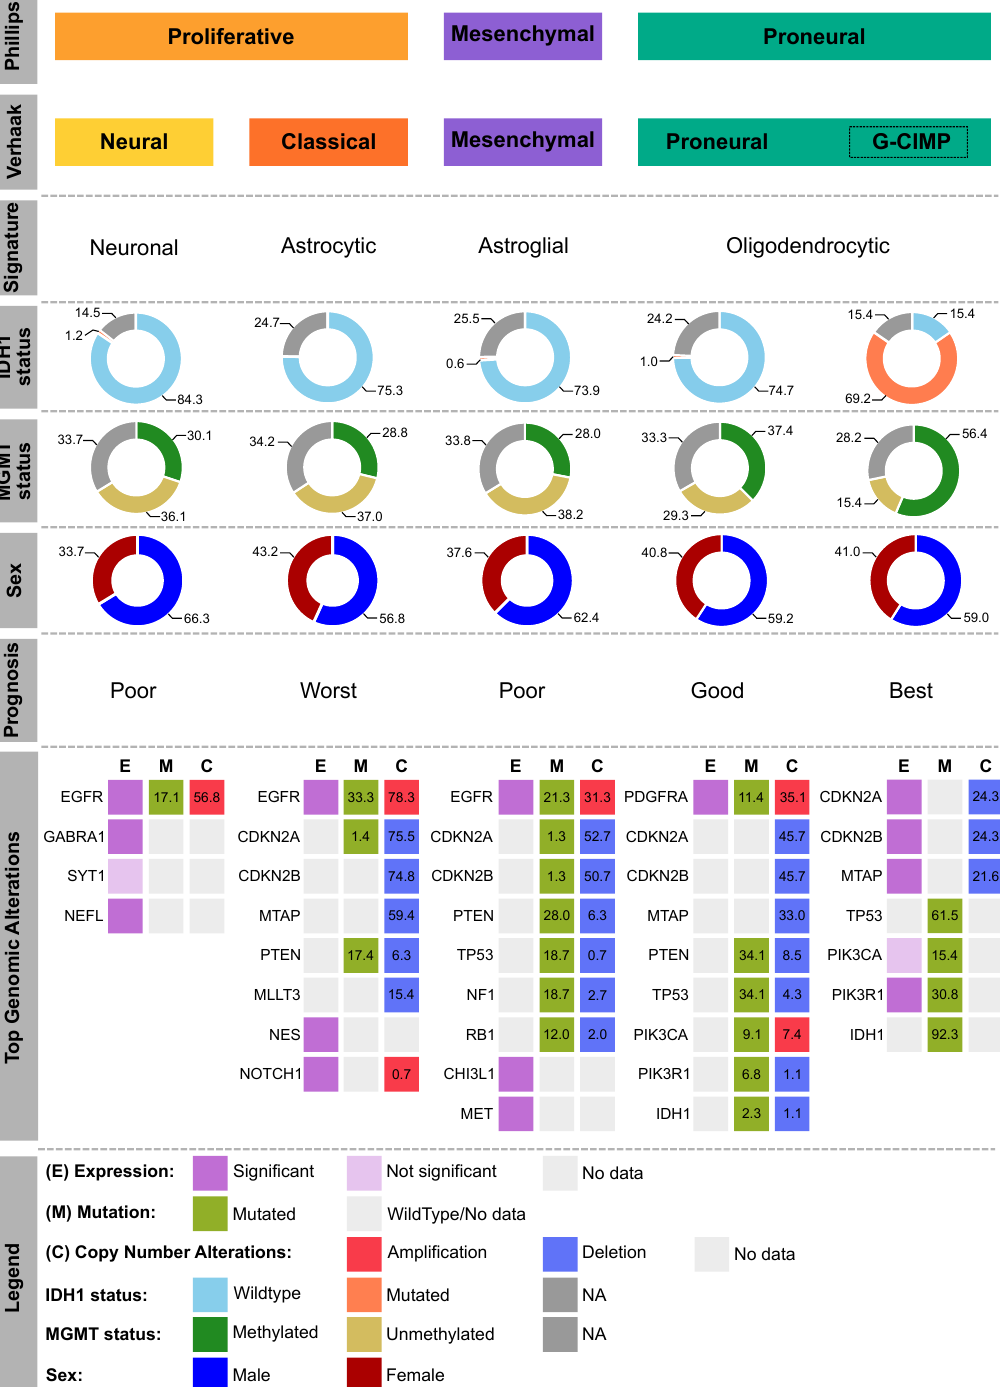
Wildtype Mutated NA IDH1